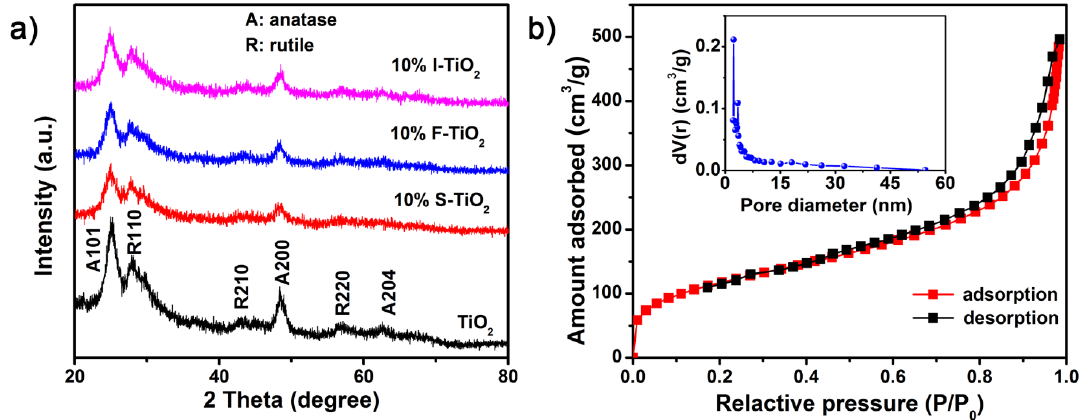
Figure 2. ( a ) X-ray diffraction (XRD) patterns of pure TiO 2 , 10% F-TiO 2 , 10% I-TiO 2 , 10% S-TiO 2 ; ( b ) N 2 adsorption-desorption isotherms of the pure TiO 2 NSs, while the inset is the curve of pore size distribution.